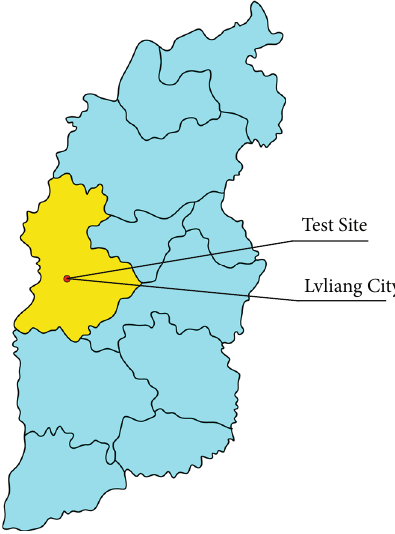
Figure 1: Geographical